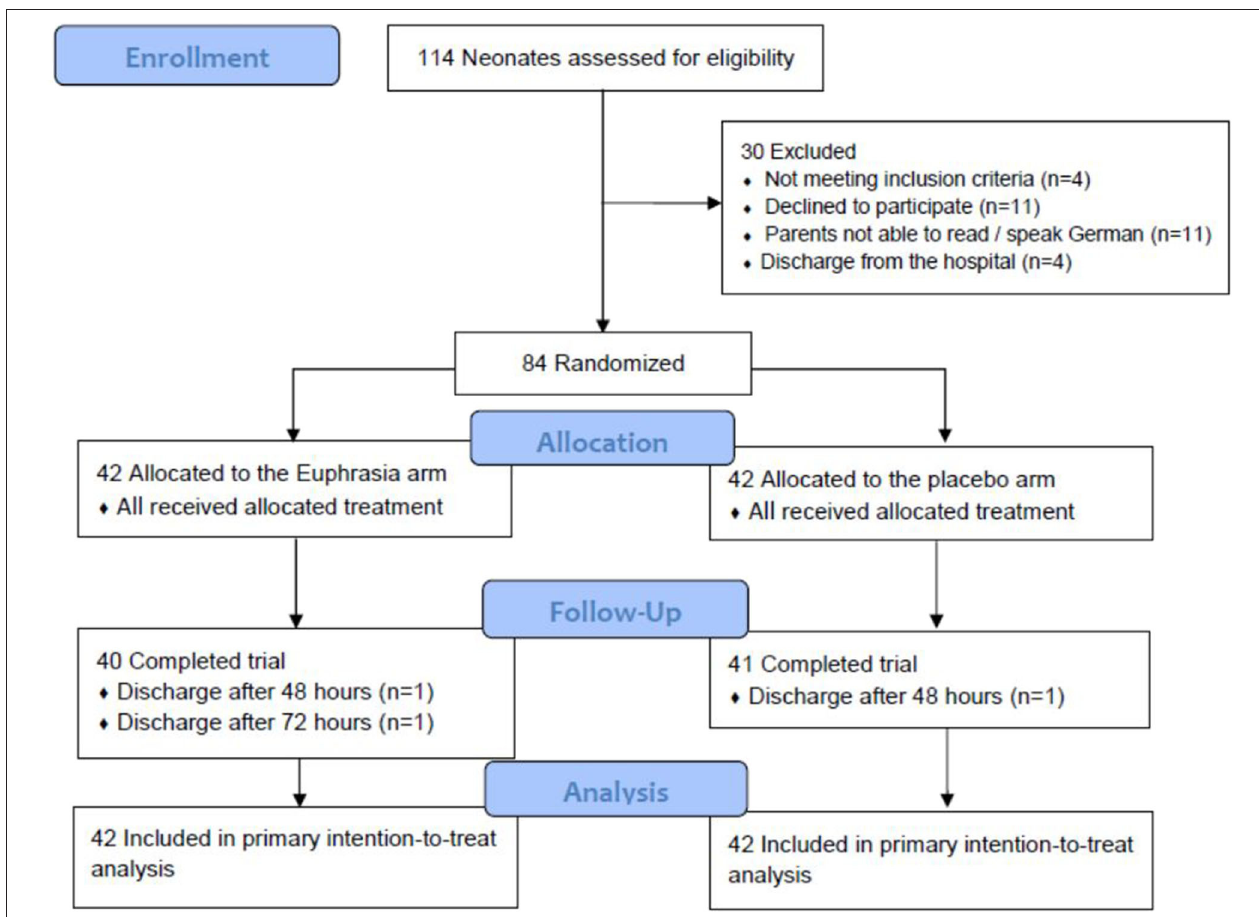
FIGURE 1 | Participant